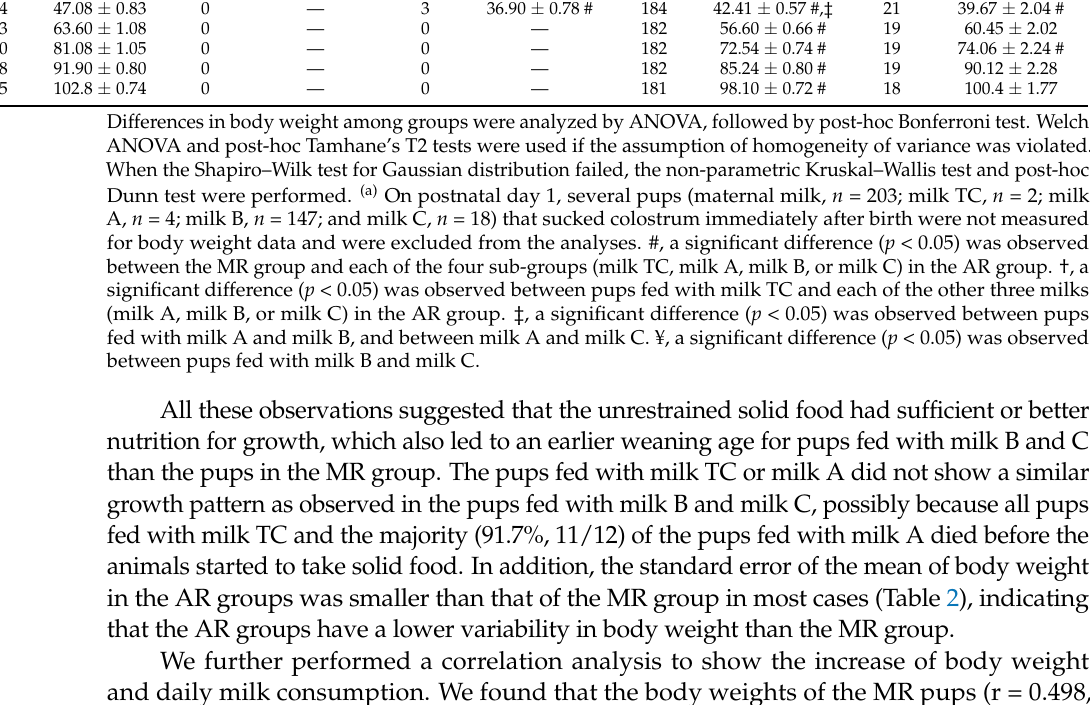
Figure 4. The correlation between body weight and daily milk consumption in the tree shrew pups fed with different milks. The correlation between body weight and daily milk consumption in pups (for pups fed with maternal milk ( A ), postnatal days 1–30; for pups fed with artificial milk ( B ), including milk A ( C ), milk B ( D ), milk C ( E ), and milk TC ( F ), postnatal days 1–24). A p value < 0.05 was considered as statistically significant; and ns, not significant. 3.4. Survival of Pups Fed with Different Milks We investigated the survival of the pups in each group fed with the different milk substitutes or breast milk. Kaplan–Meier survival analysis revealed that the feeding milk significantly affected the 60-day overall survival of the pups ( p < 0.001). The pups fed with milk B had the best overall survival, with a slightly higher rate compared with that of the MR pups, followed by pups fed with milk C.